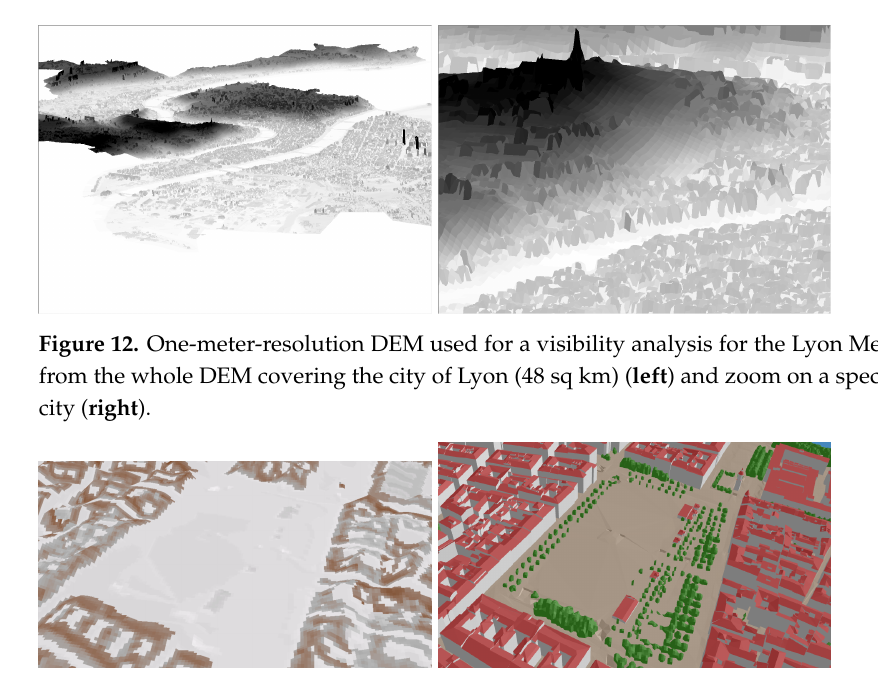
Figure 13. Visual comparison between data describing the same location (Bellecour square): raster data (1-m DEM— left ) and 3D vector data ( right